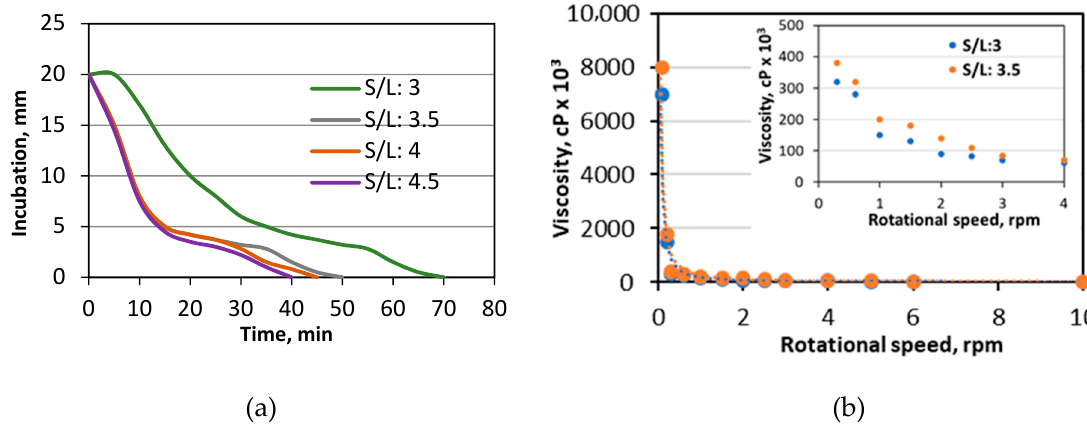
Figure 4. Effect of S/L ratio on the ( a ) setting time and ( b ) viscosity of geopolymer pastes with [KOH]: 8M. and curing temperature 70 °C.